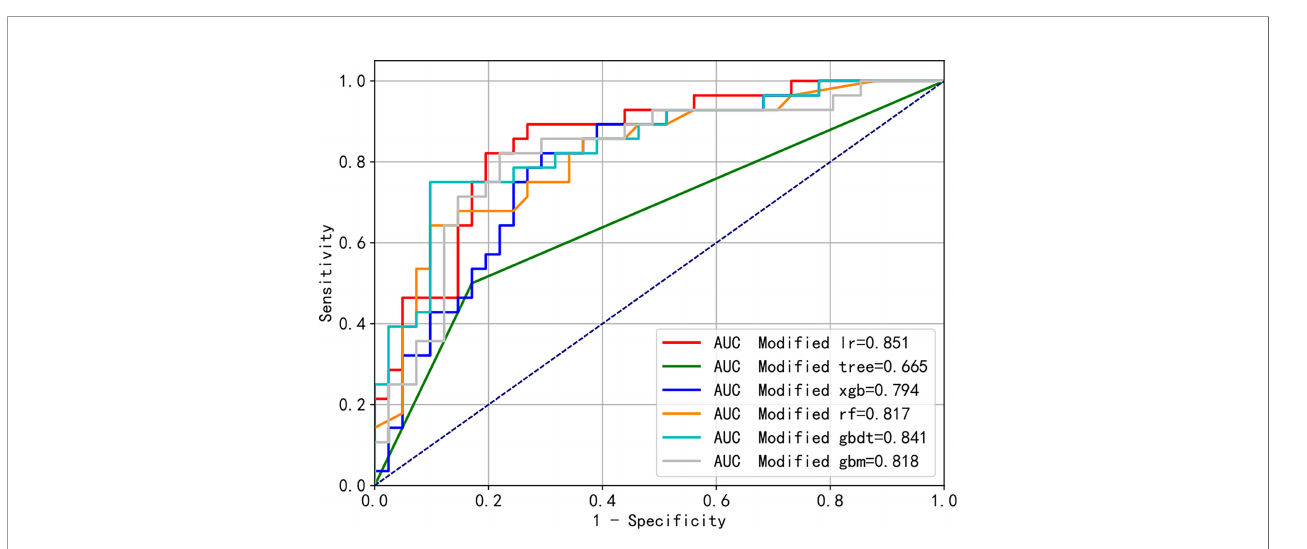
FIGURE 6 | Modi fi ed receiver operating characteristic (ROC) curves of the different machine learning algorithms predicting blood